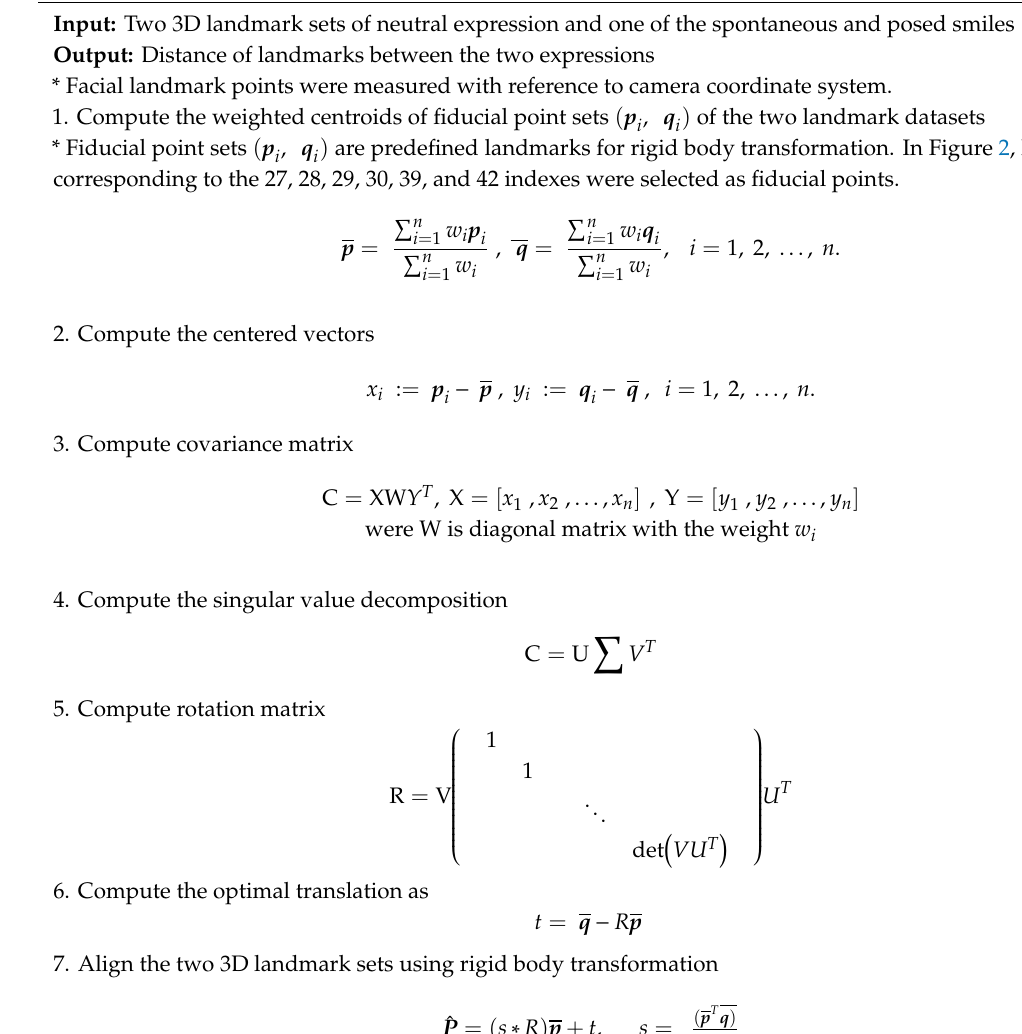
Algorithm 1. Left and Right Facial Movement Measurement